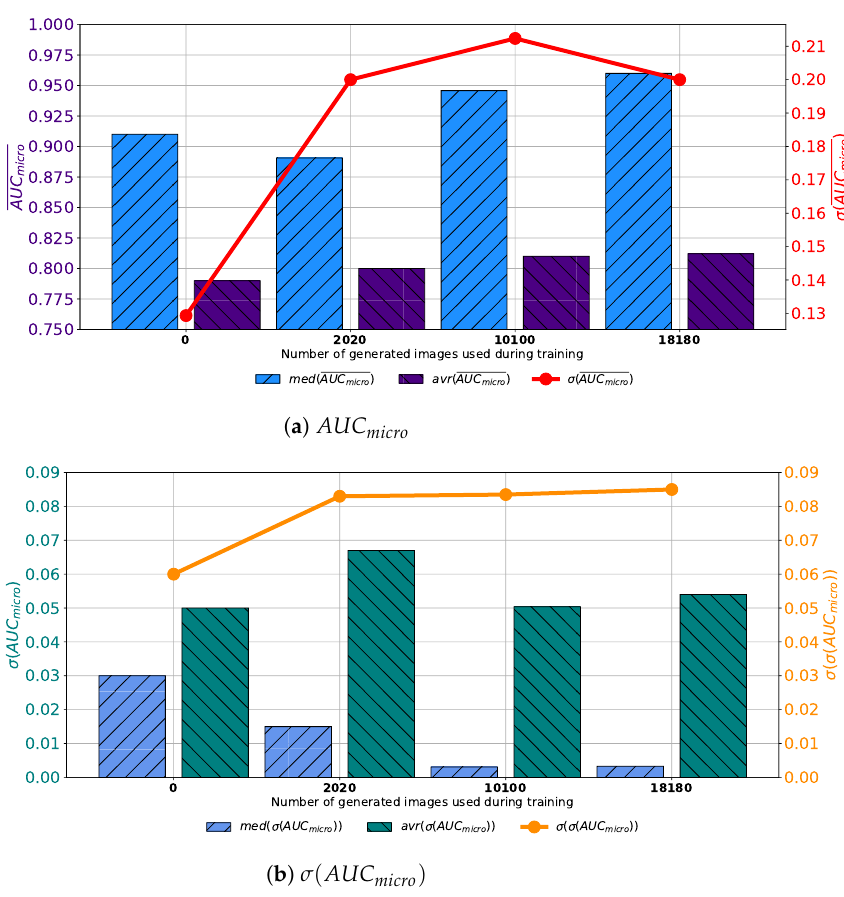
Figure 13. Median, average AUC micro and standard deviation of AUC micro and σ ( AUC micro ) for the case of VGG-16 trained with images generated by GAN in 500